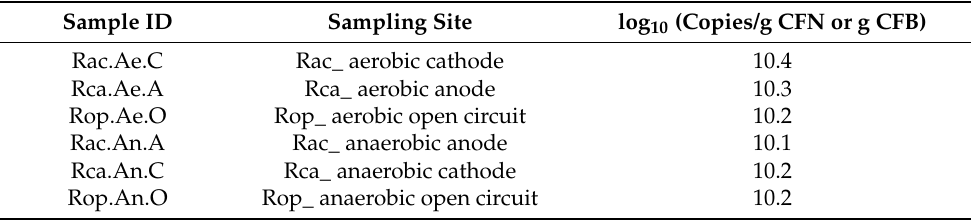
Table 2. Q-PCR quantification of total microbial community in the biofilm